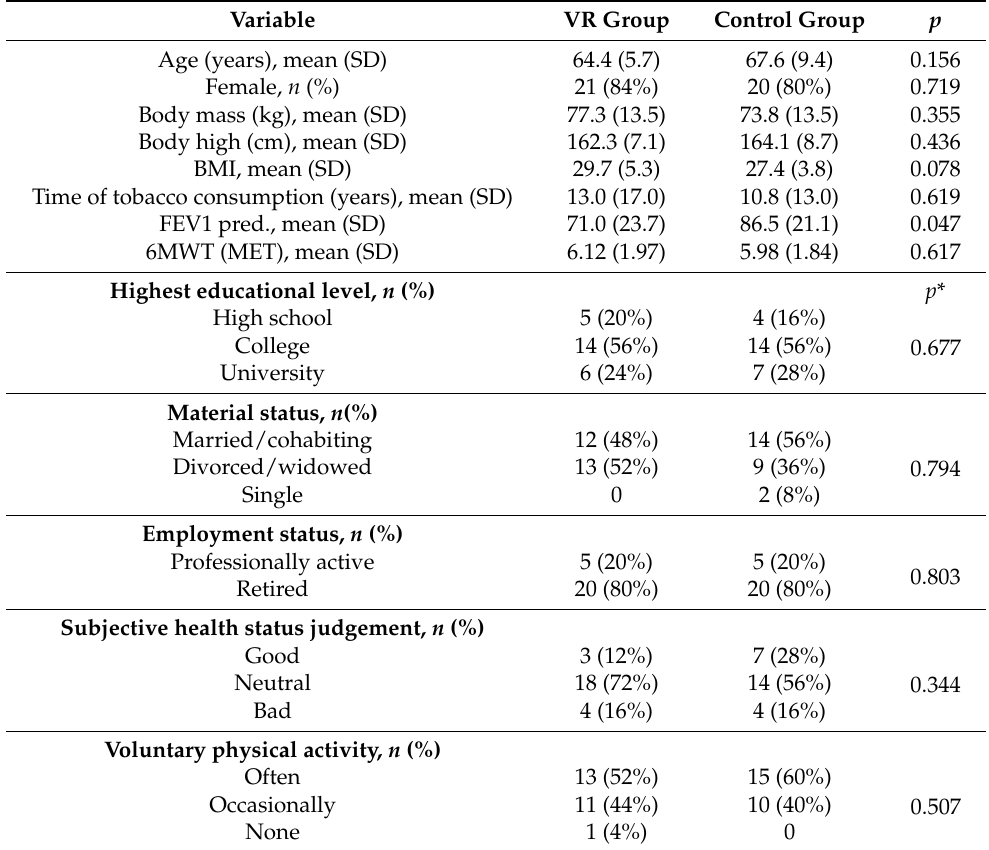
Table 1. Baseline sociodemographic and clinical